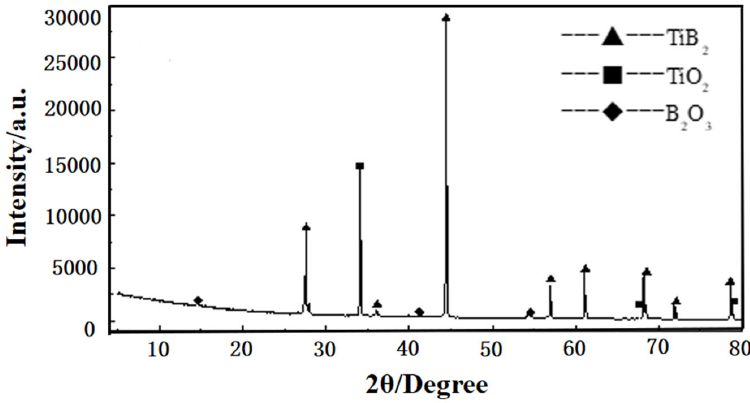
Figure 3. X-ray diffraction (XRD) patterns of plasma-sprayed TiB 2 coating.